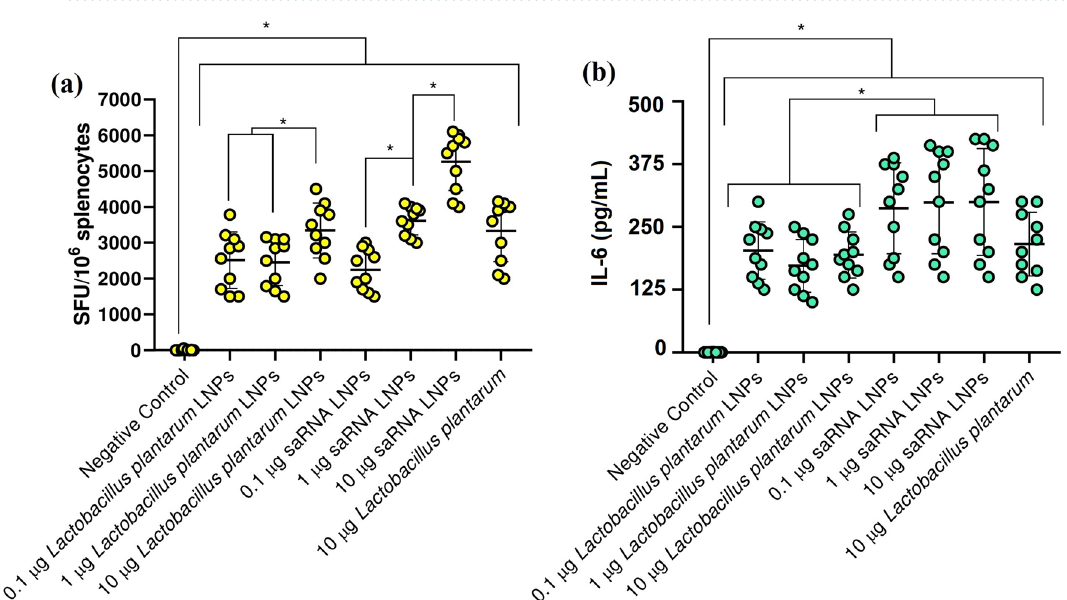
Figure 4. The count of splenocytes from mice vaccinated with saRNA LNPs, transfected Lactobacillus plantarum LNPs, and transfected Lactobacillus plantarum alone when re-stimulated with SARS-CoV-2 peptides by IFN-γ ELISpots ( a ). The secretion of IL-6 ( b ) by re-stimulated splenocytes. * indicates significance difference with P < 0.05 using one-way ANOVA with n = 10 biologically independent mice. All data were shown as mean ±